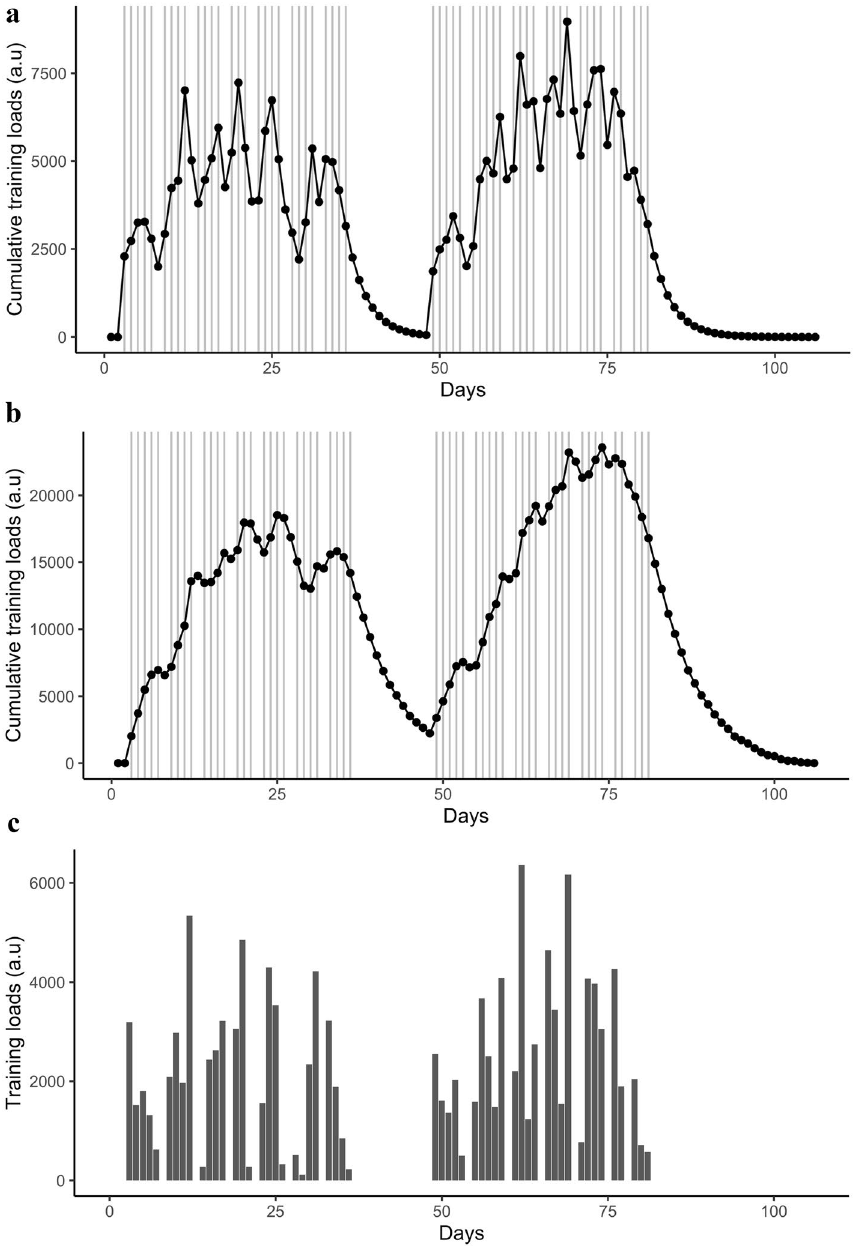
Figure 1. Cumulative daily training loads of a representative athlete following ( a ) the impulse response function ( X 2 , Eq. 1) and ( b ) the serial bi-exponential response function ( X 3 , Eq. 2). ( c ) illustrates the raw daily training loads X 1 , expressed by w(t). In ( a ) and ( b ), dots represent daily values of the cumulative training load and vertical solid lines indicate occurrence of training sessions. Values are represented in arbitrary units